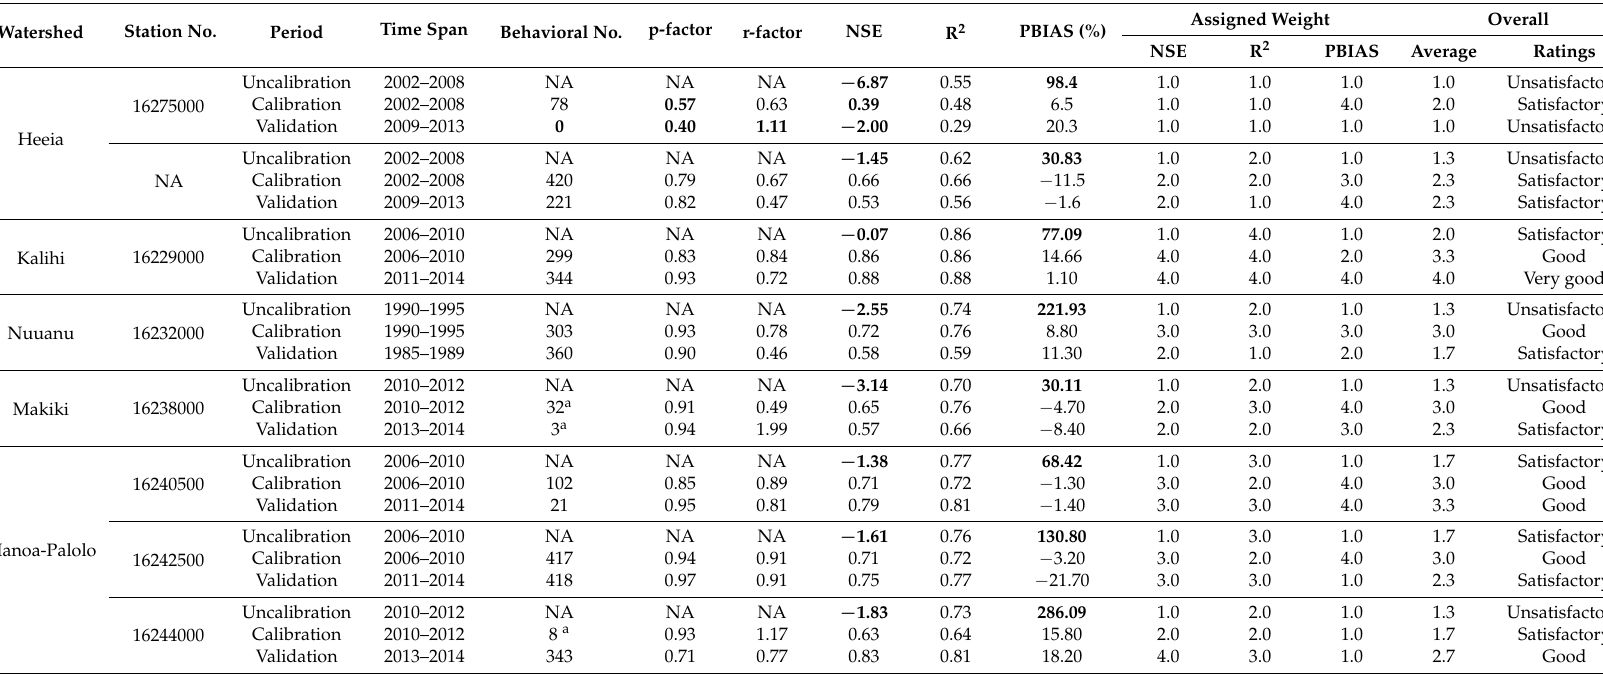
Table 5. Goodness-of-fit statistics for daily streamflow simulations at Heeia and Nuuanu area watersheds using rain gauge data. Bold signifies unsatisfactory.